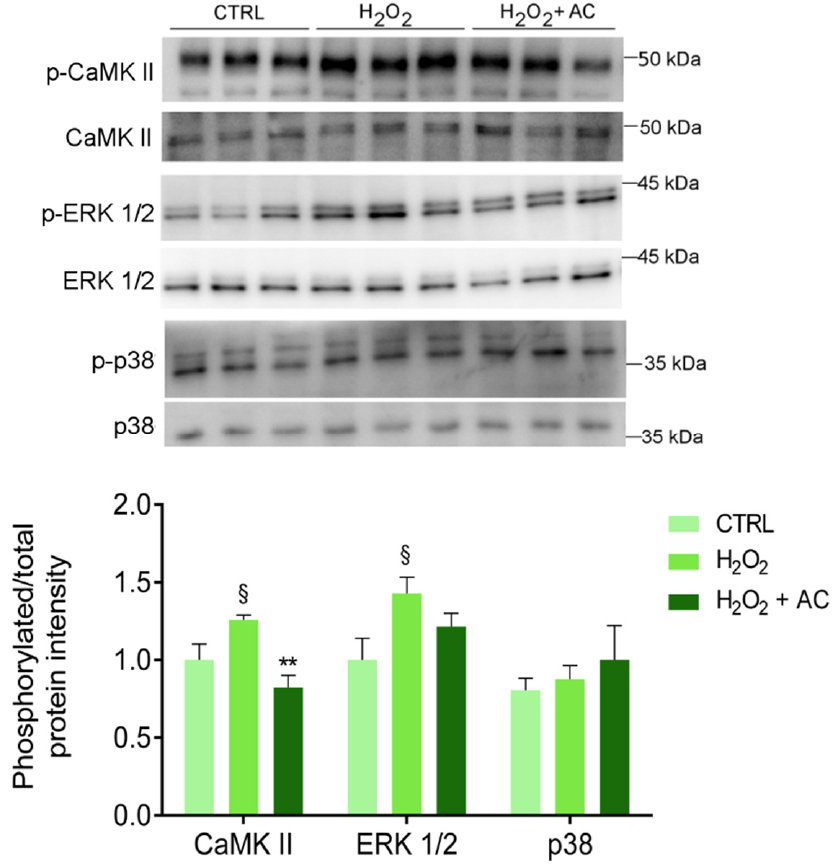
Figure 7. The H 2 O 2 -induced activation of CaMKII is rescued by AC (200 µg/mL) treatment. Protein lysates derived from rat brain slices (treated as described in Materials and Methods) were analysed by WB using antibodies against the phosphorylated isoforms of CaMKII, p38, and ERK 1/2 or their corresponding total protein. The upper panel shows a representative WB, while the bar diagram shows the ratio between p-CaMKII and CaMKII, p-p38, and p38, or p-ERK1/2 and ERK1/2 band intensity, respectively. § p < 0.05 vs. CTRL, ** p < 0.01 vs. H 2 O 2 (ANOVA followed by Holm Sidak’s multiple comparison test).